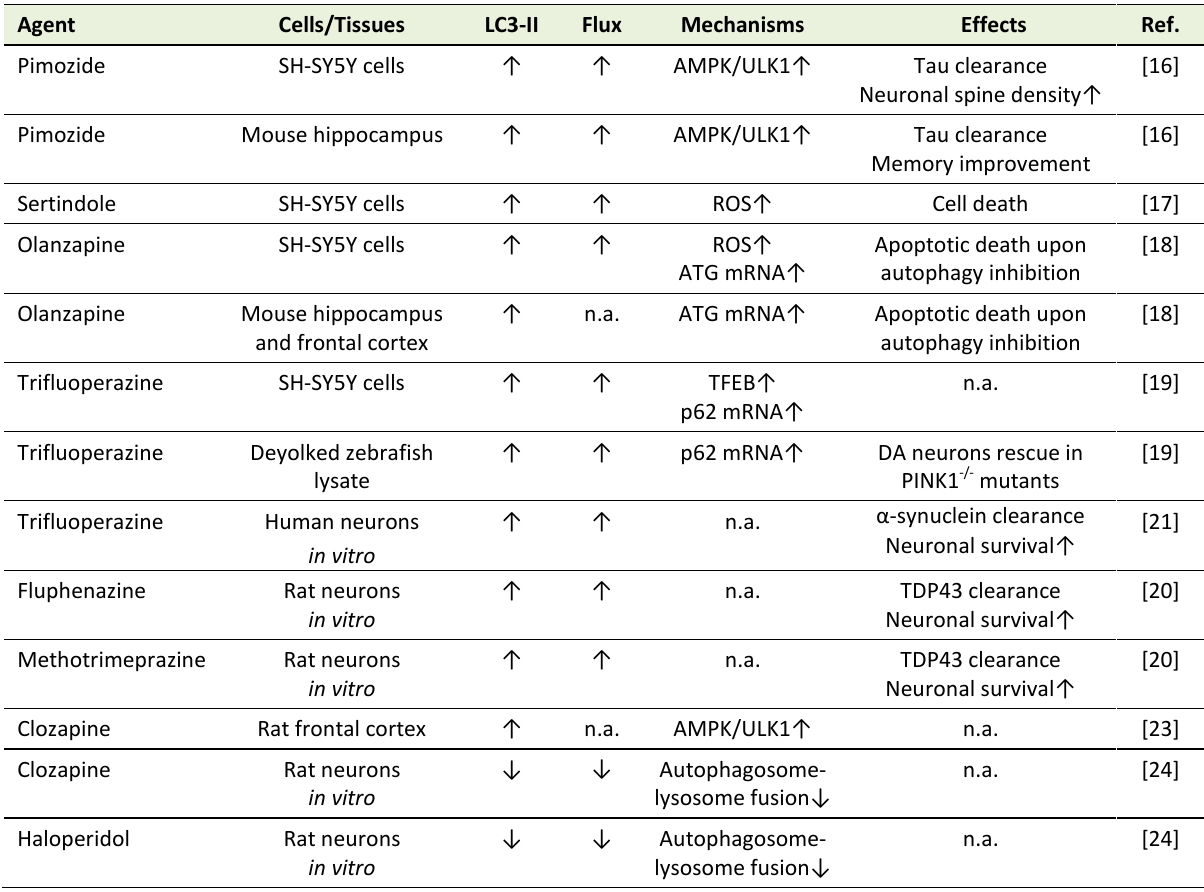
Table 1. Modulation of neuronal/brain autophagy by antipsychotics.